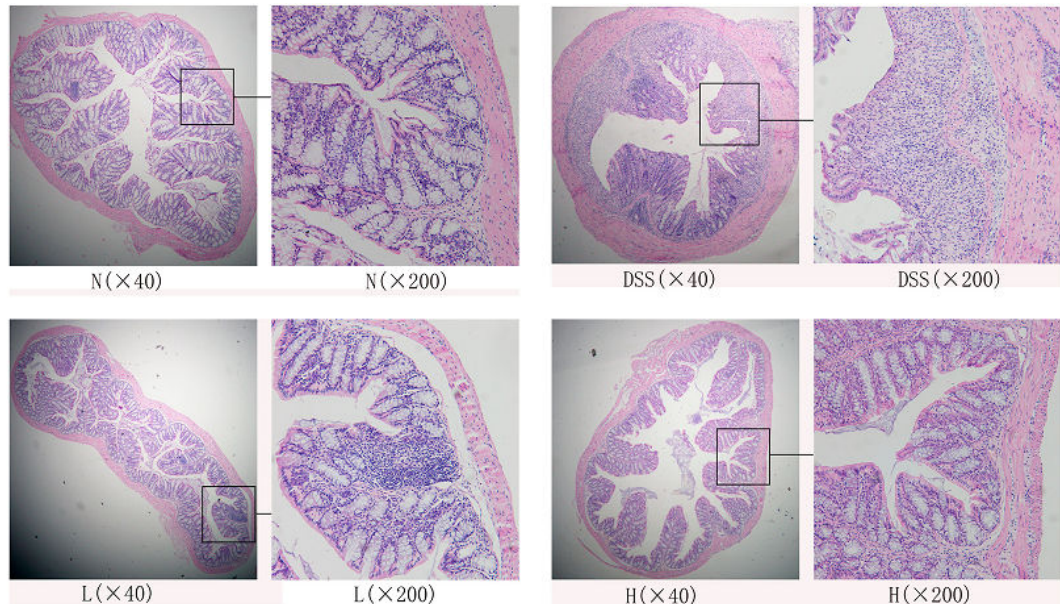
Figure 3. Histopathology observation of colon. N (normal group), DSS (model group), L (low dose group, 10 9 CFU/kg · bw), H (high dose group, 10 10 CFU/kg · bw).